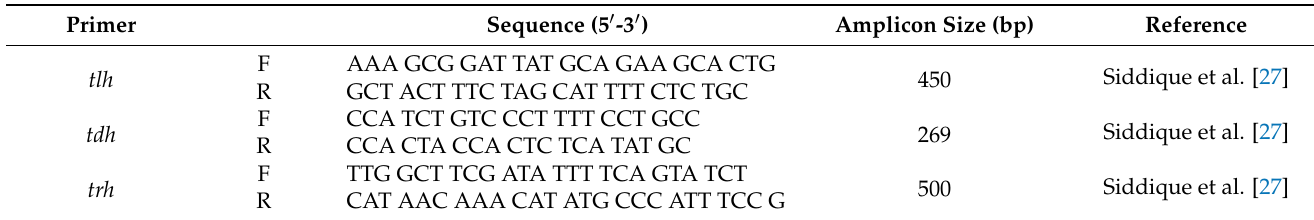
Table 2. Primers selected for the detection of virulence genes of V. parahaemolyticus . Primer Sequence (5 (cid:48) -3 (cid:48) ) Amplicon Size (bp)